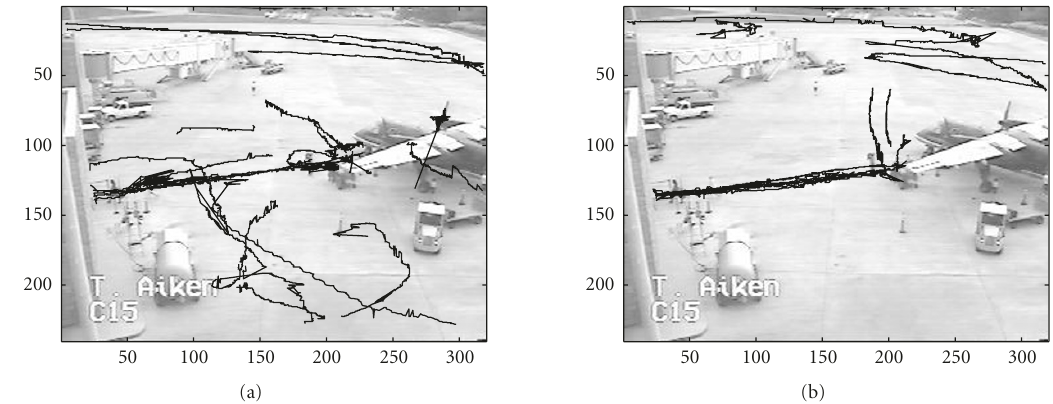
Figure 1: TSA airport tarmac surveillance dataset. Each image represents a block of 10000 frames along with motion trajectories extracted.